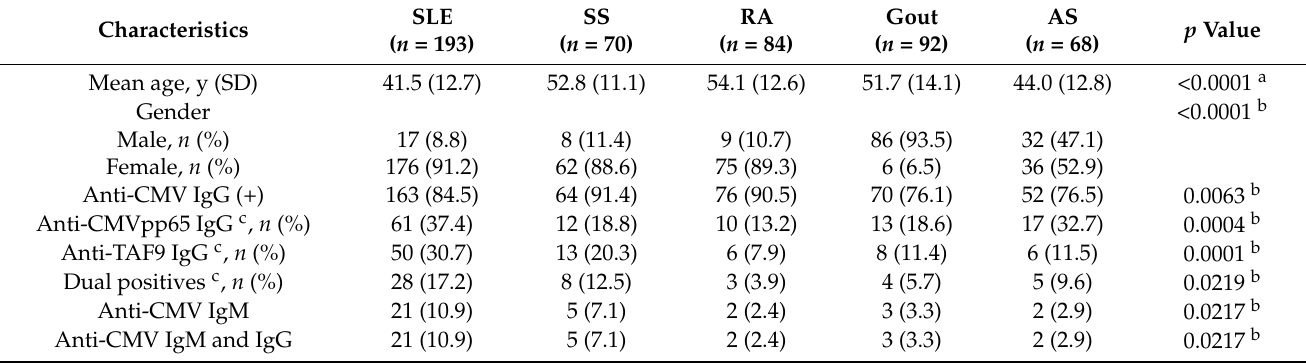
Table 1. Antibody responses to CMV, CMVpp65, and human TAF in rheumatic patients.